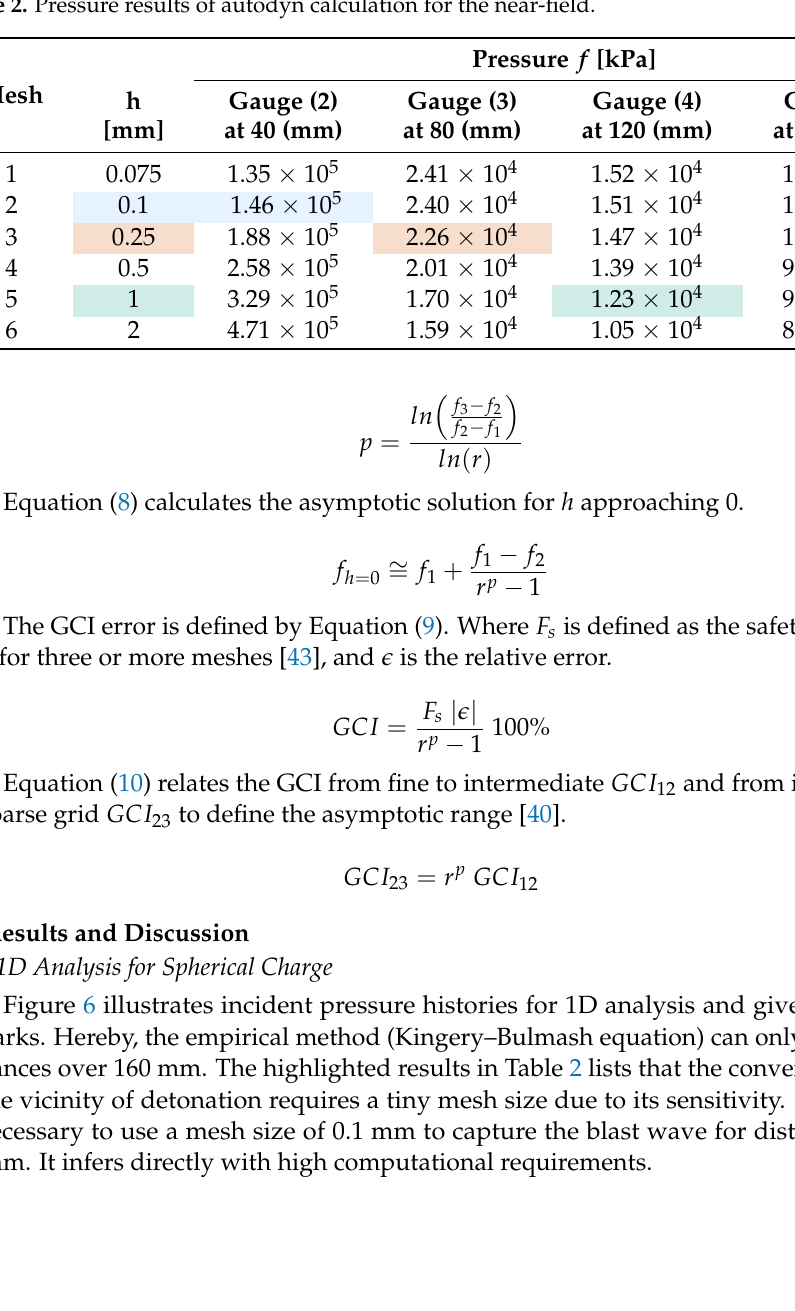
Table 2. Pressure results of autodyn calculation for the